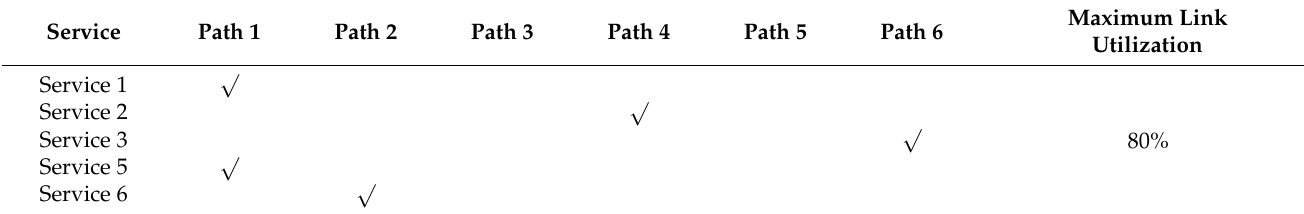
Table 6. Service status after path